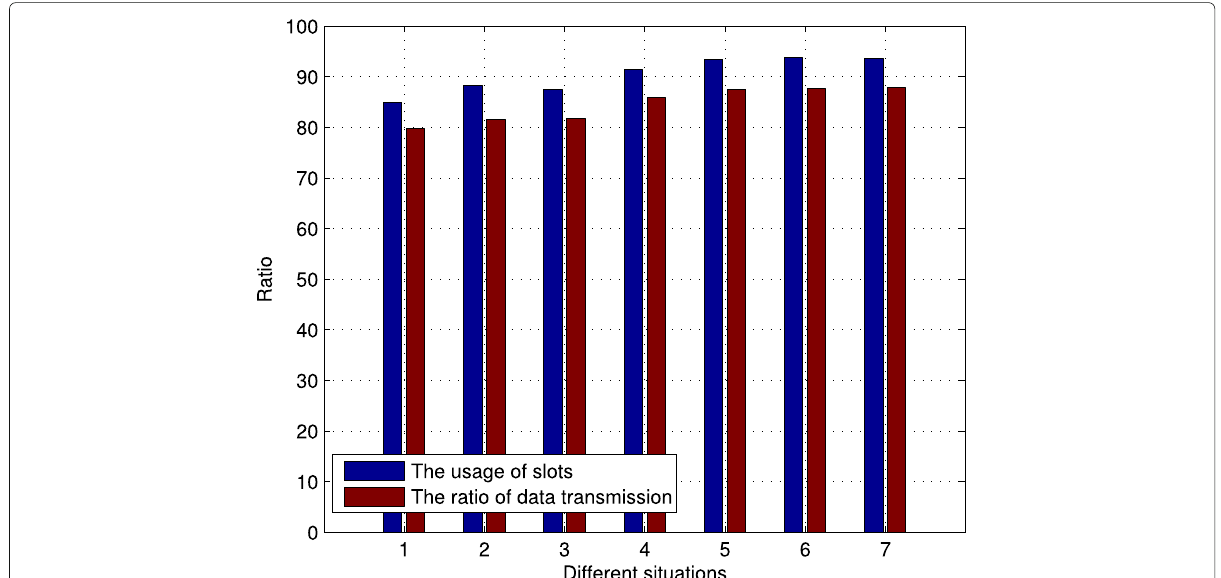
Fig. 6 The efficiency of slot usage and data uploading. The figure shows the efficiency of slot usage and data uploading under different